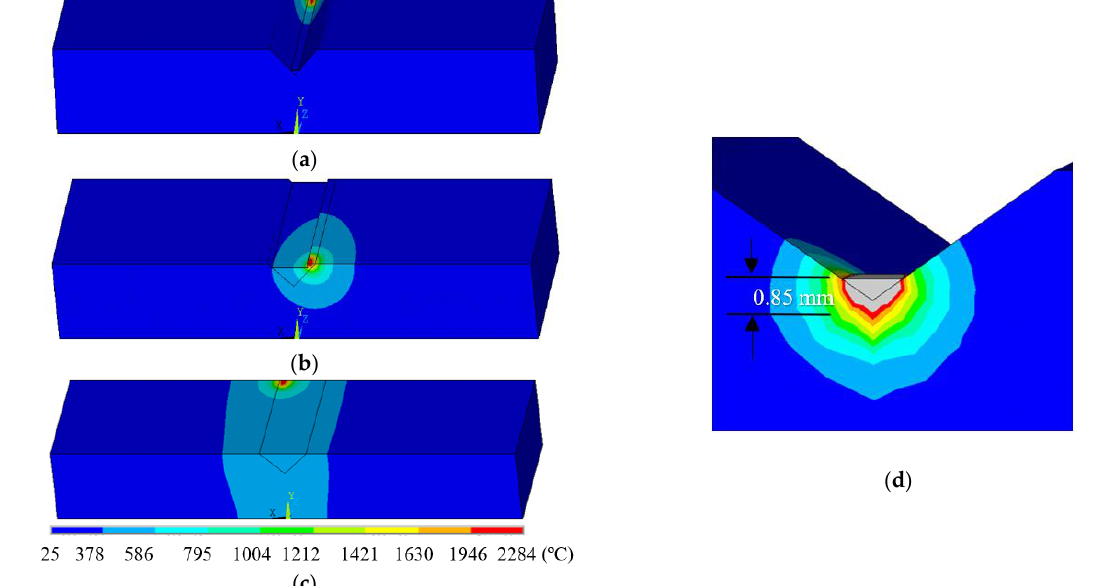
Figure 7. Temperature distribution at the end of the n th track, n is 1 ( a ), 16 ( b ), and 21 ( c ). The zoom-in temperature contours of the first track are shown in ( d ).